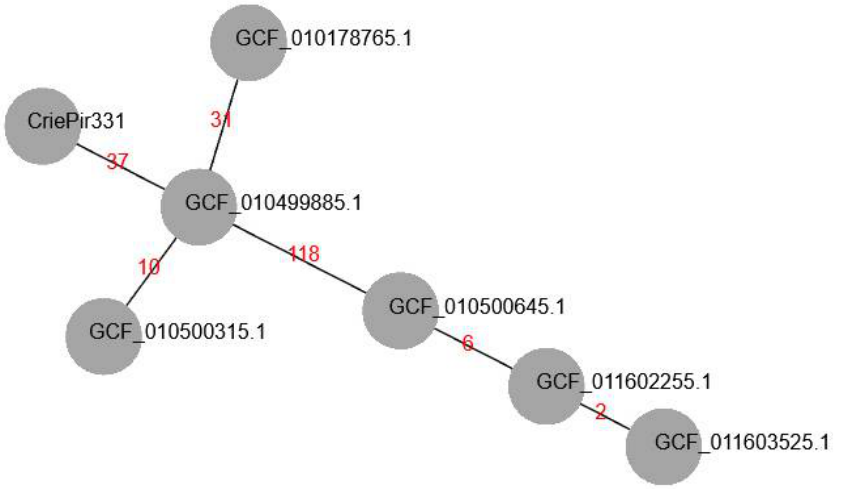
Figure 1. Minimum-spanning tree (MST) of cgMLST allelic profiles build for CriePir331 and ST2 isolates from RefSeq database having the closest profiles to CriePir331. The branch labels indicate the number of differing alleles. All isolates from RefSeq were obtained in the same medical center in India in 2020.